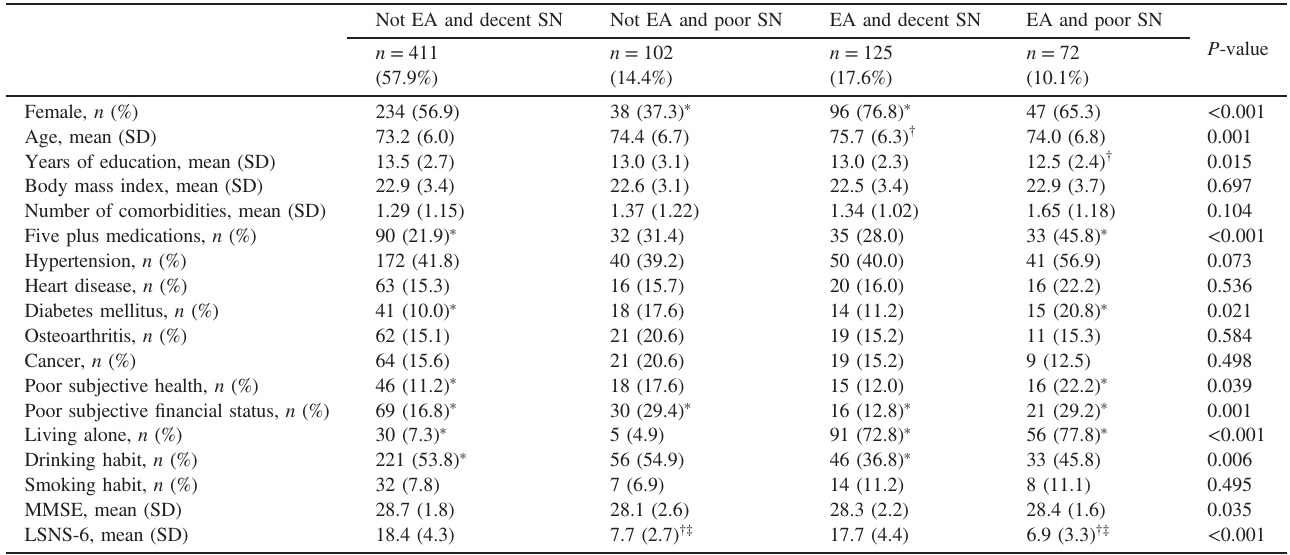
Table 1. Participant characteristics strati fi ed by the combinations of eating style and social network